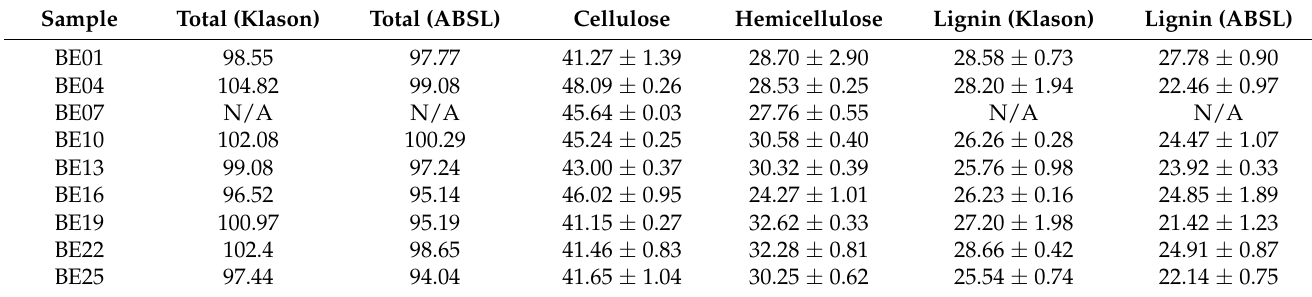
Figure 1. Lignocellulosic composition of various Miscanthus cultivars: ( A ) lignin content of Miscanthus cultivars using either the Klason method or the ABSL method; ( B ) comparison of cellulose, hemicellulose and lignin of Miscanthus samples harvested in early and late harvests. Data representative of triplicate values. Table 2. Cellulose, hemicellulose and lignin content (%, w / w ) of Miscanthus